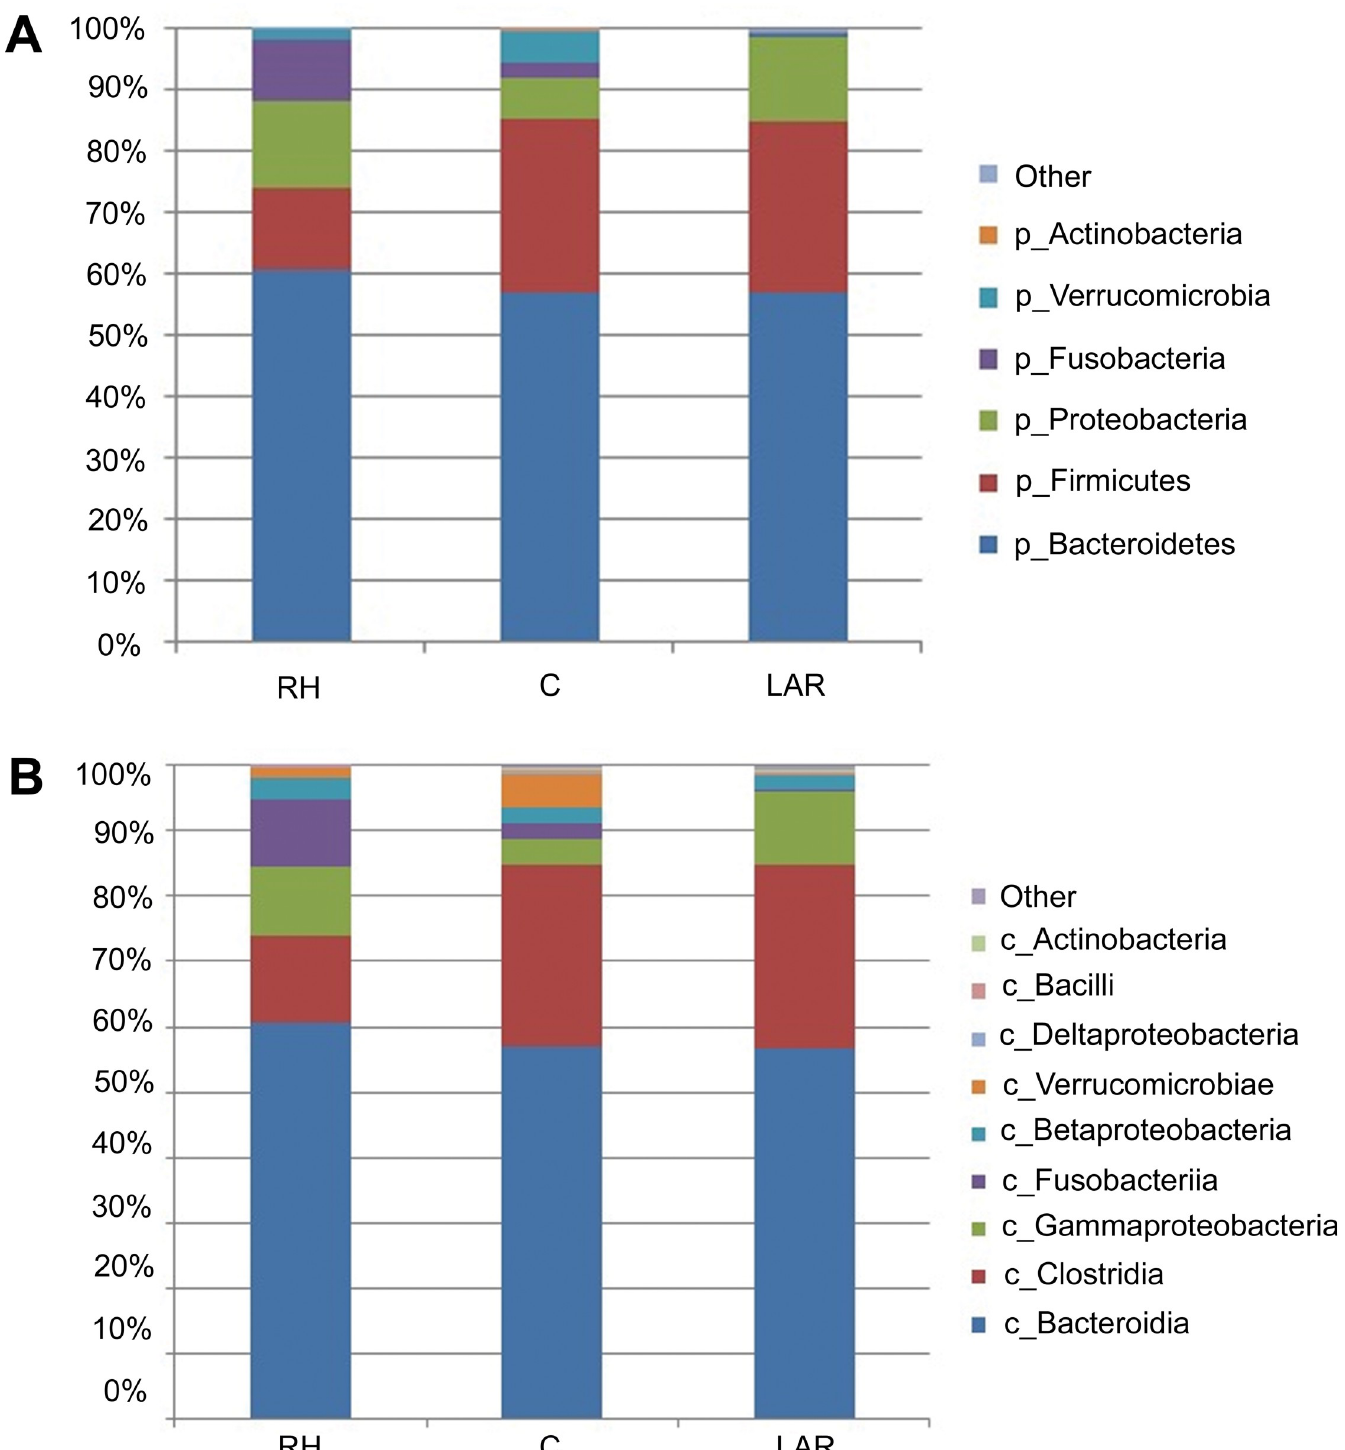
Fig 3. Relative abundances of classes across three groups. Relative abundances of phylum across right hemicolectomy (RH), low anterior resection (LAR), and control groups (Fig 3A). Relative abundances of classes across right hemicolectomy (RH), low anterior resection (LAR), and control groups (Fig 3B).